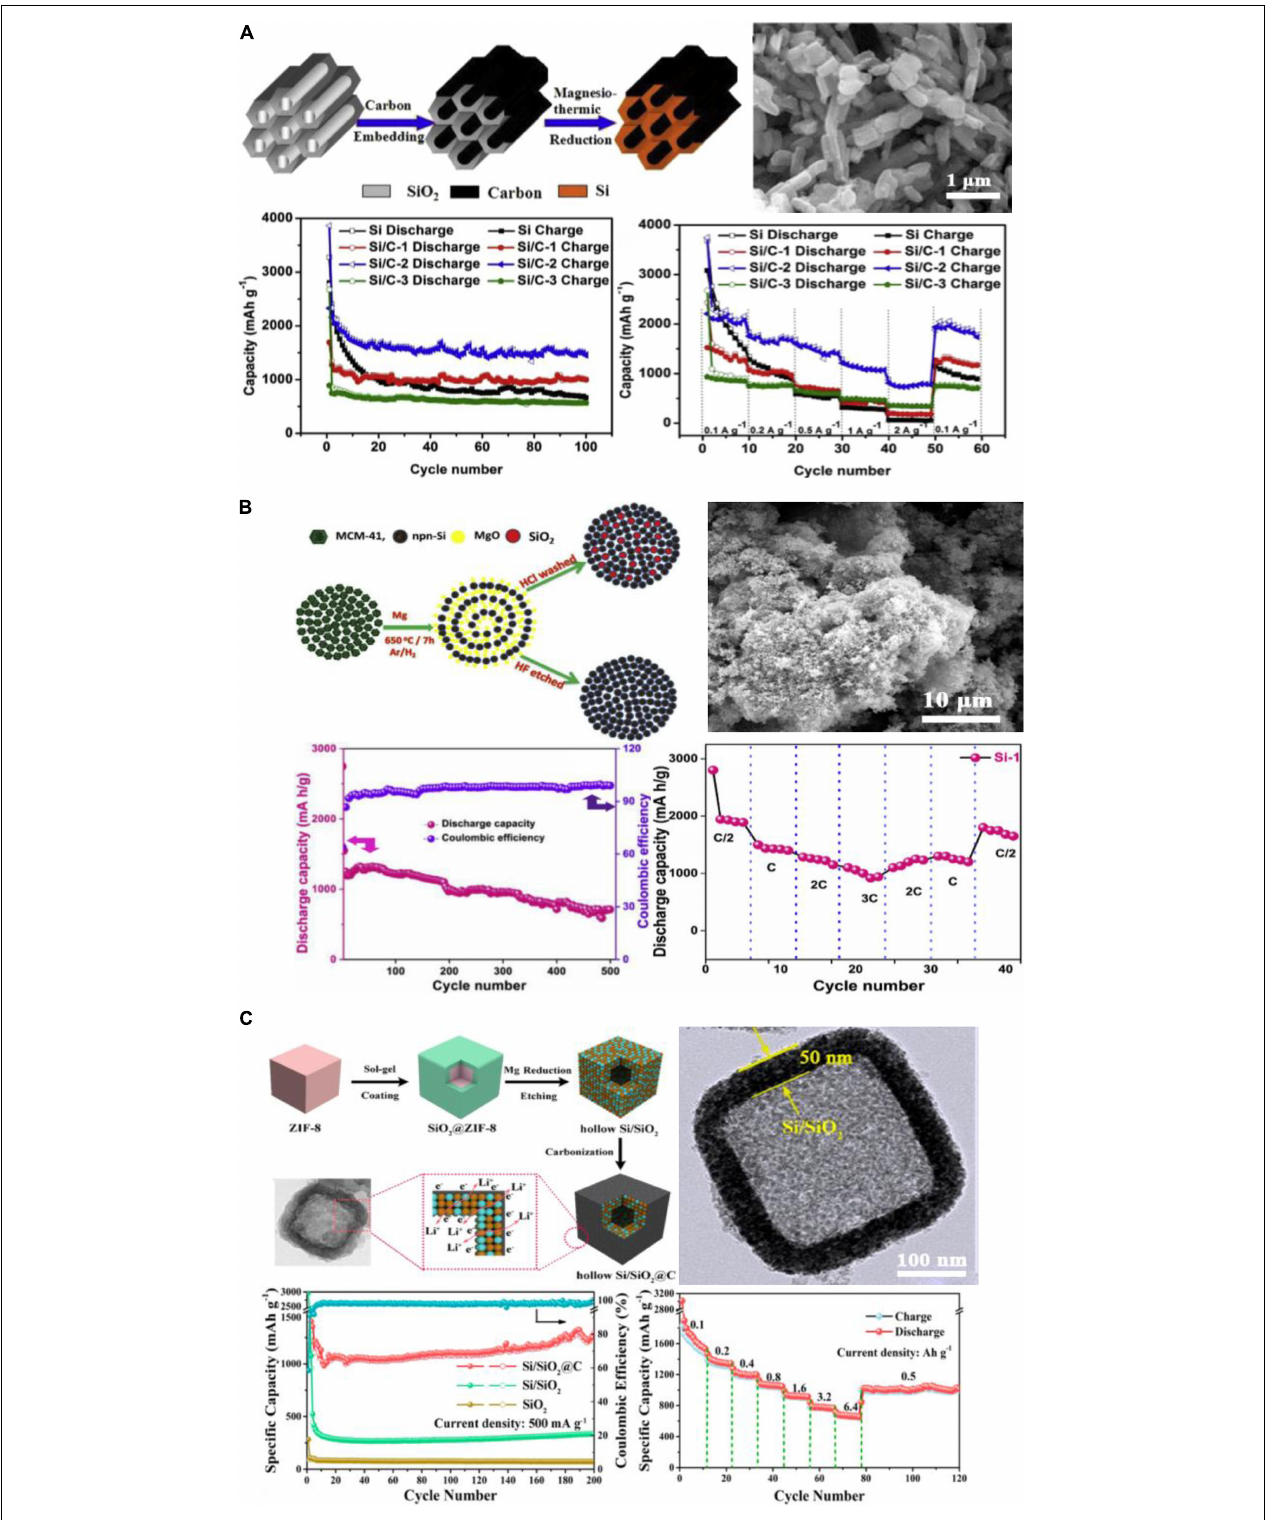
FIGURE 10 | (A) Fabrication, SEM, and electrochemical performance of ordered porous Si from SBA-15. Reprinted from Ref. (Li et al., 2015), with the permission of Elsevier. (B) Fabrication, SEM, cycle and rate performance of porous Si from reduction of MCM-41. Reprinted from Ref. (Shivaraju et al., 2019), with the permission of Elsevier. (C) Fabrication, TEM, and electrochemical performance of hollow Si/SiO 2 @C using sacrificial template. Reprinted from Ref. (Wang et al., 2018), with the permission of American Chemical Society.